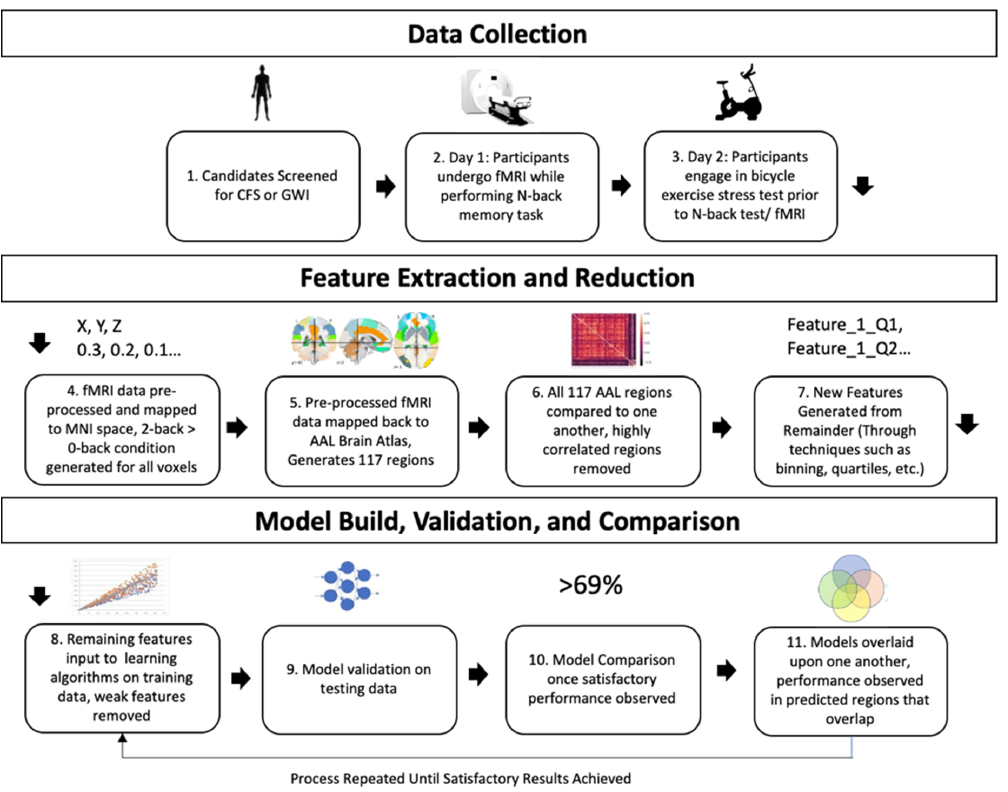
Figure 1. Overview of data collection methodology and model build. It is important to note